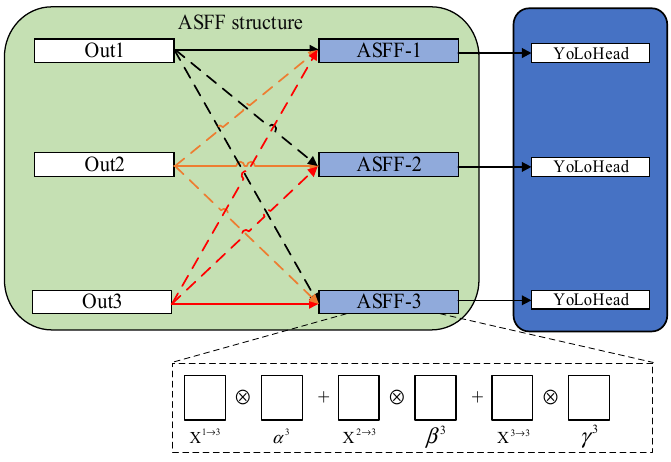
Figure 12. The ASFF model after being improved.